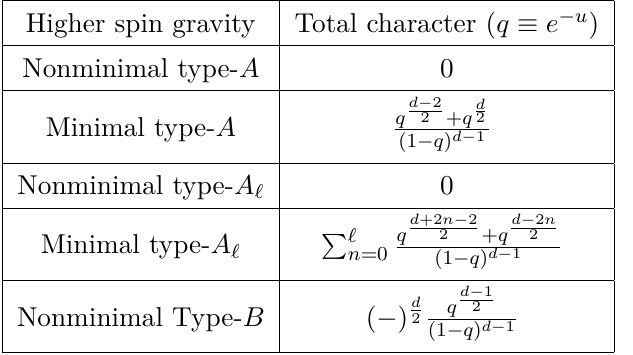
Table 1. The total characters of various higher spin gravity